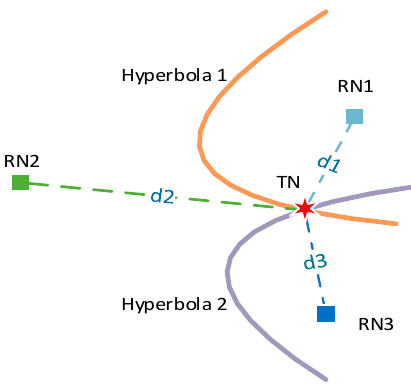
Figure 1. Basic architecture of TDOA-based localization system.